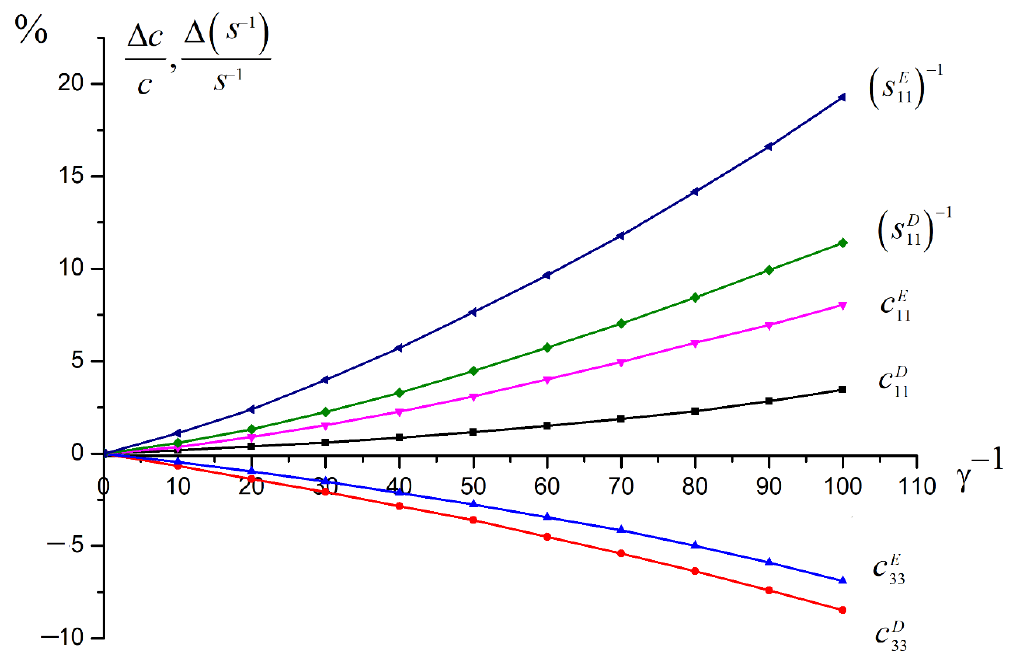
(cid:1) − 1 (cid:0) (cid:1) − 1 ( Figure 1. Relative change in the reverse flexibilities (cid:0) s E s D (1) and (2) and in the elastic 11 11